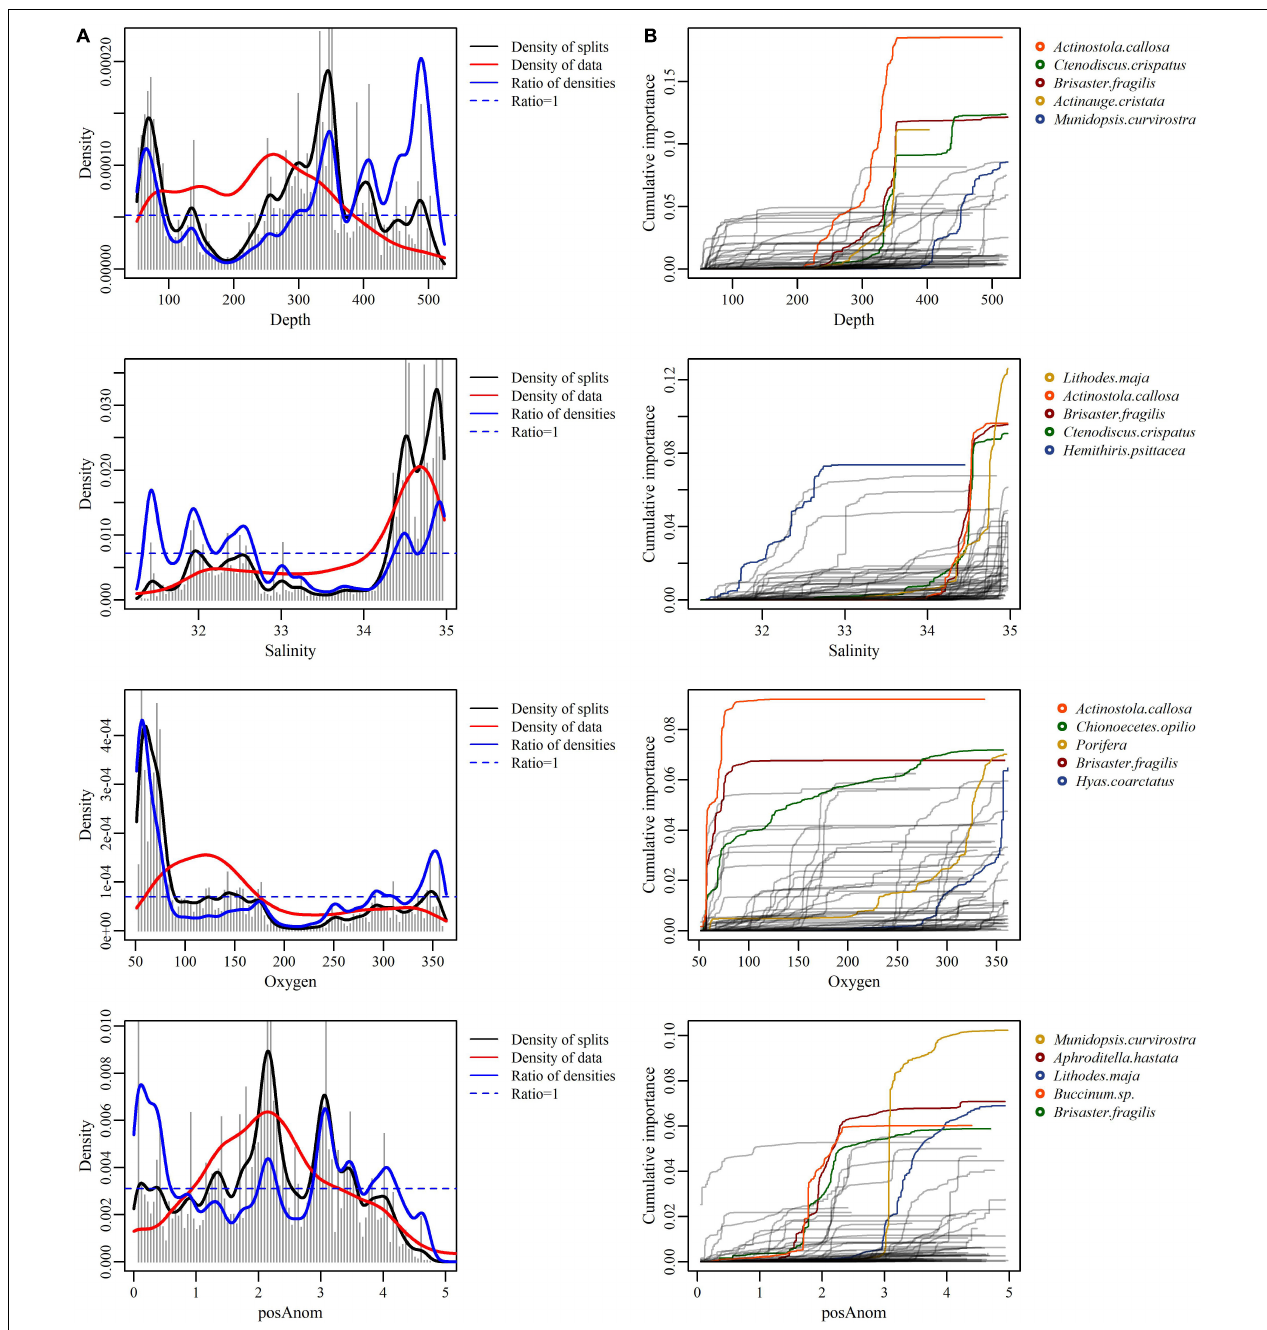
FIGURE 5 | Splits density (A) and cumulative distributions of the standardized splits importance (B) for each taxon scaled by R 2 of the four most important predictors of the distribution of epibenthic taxa in the estuary and Gulf of St. Lawrence. (A) Each curve represents an individual taxon (number of taxa = 104). Only the 5 species the most responsive to each predictor are displayed in color. (B) Density plots contain four components: gray vertical bars represent the binned raw importance of a predictor, the black line shows the density of splits estimated by kernel density, the red line indicates the density of actual predictor values (Beazley et al., 2015). The blue line is a combination of these two last components—the expected density of splits if the predictor had been sampled in uniform density, calculated as the density of splits standardized by the density of predictor values (i.e., the black line standardized by the red line) (Beazley et al.,